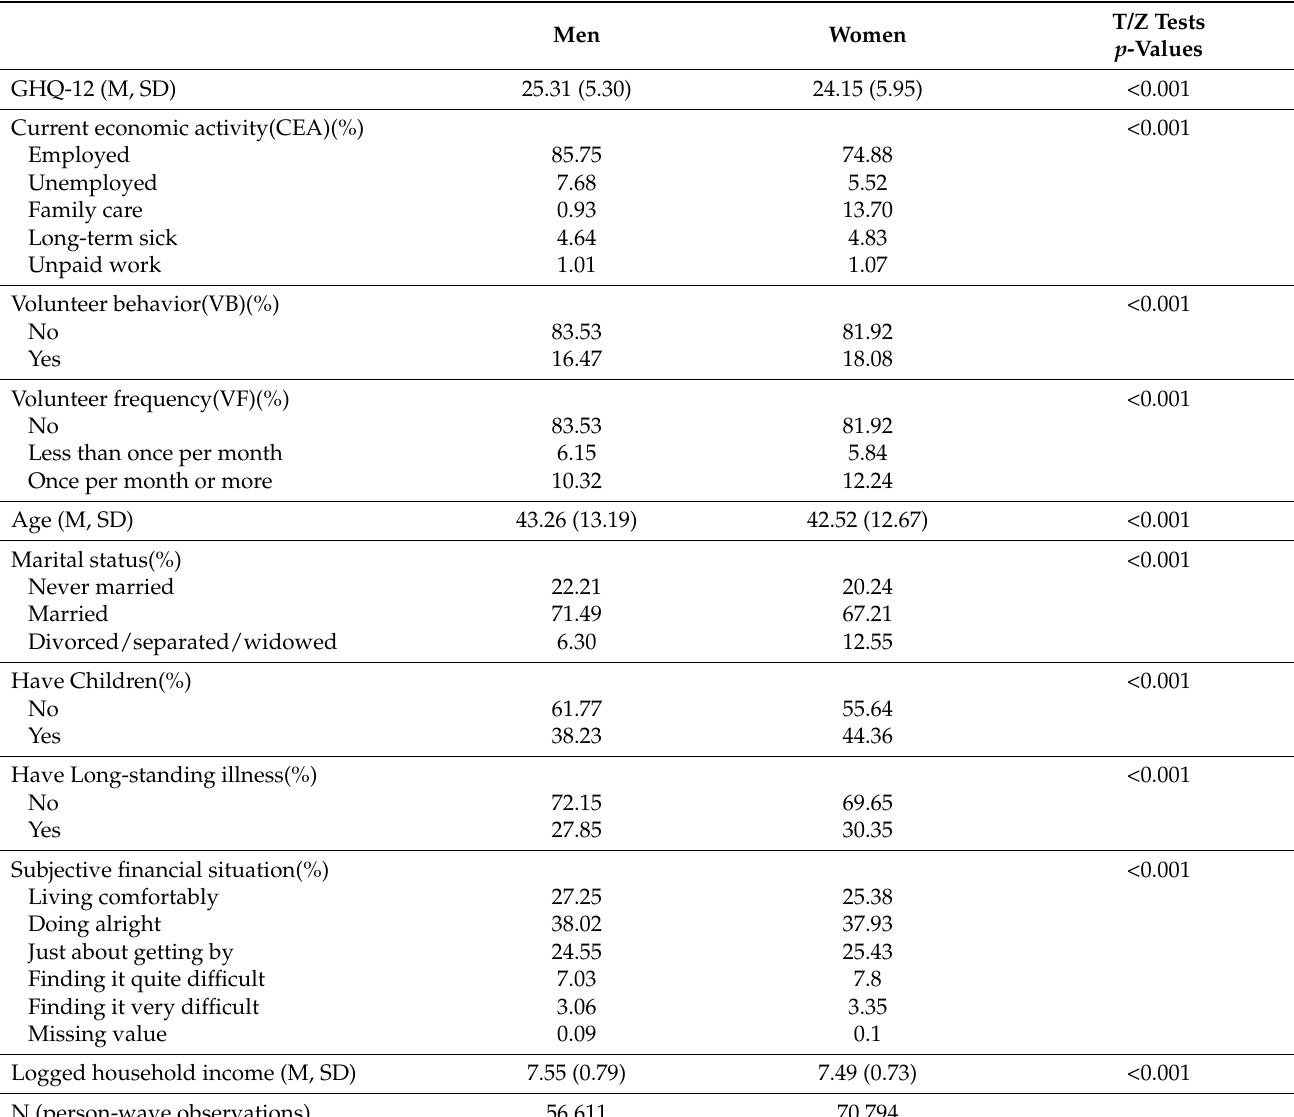
Table 1. Unweighted descriptive statistics by gender (UKHLS